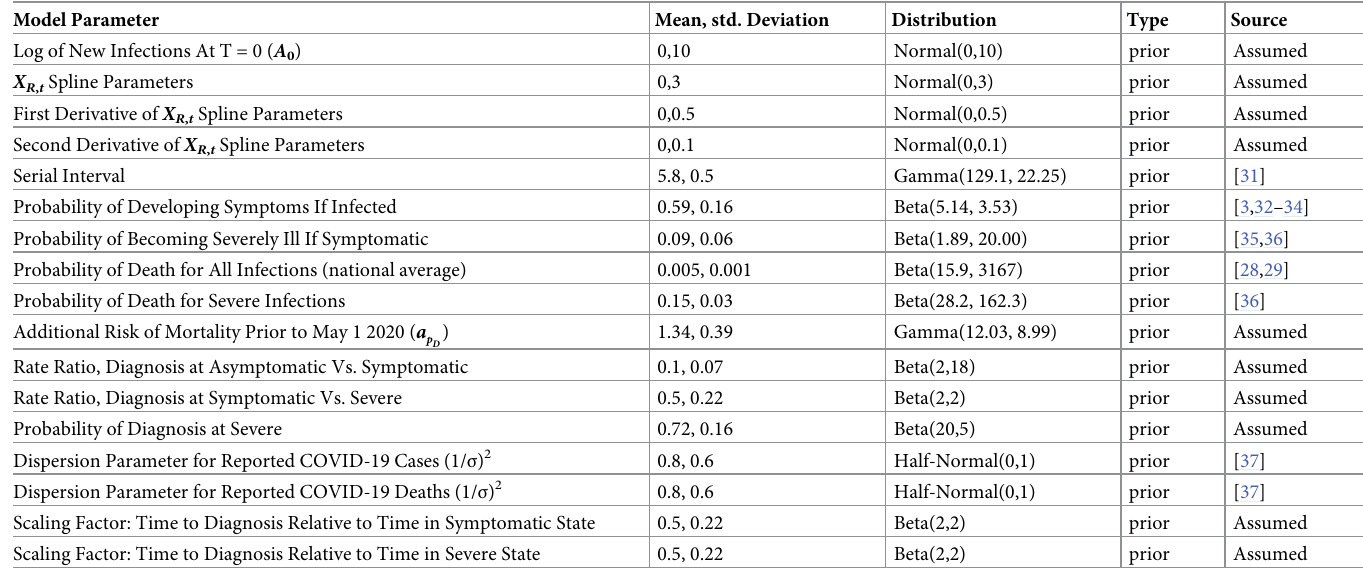
Table 1. Model parameters.